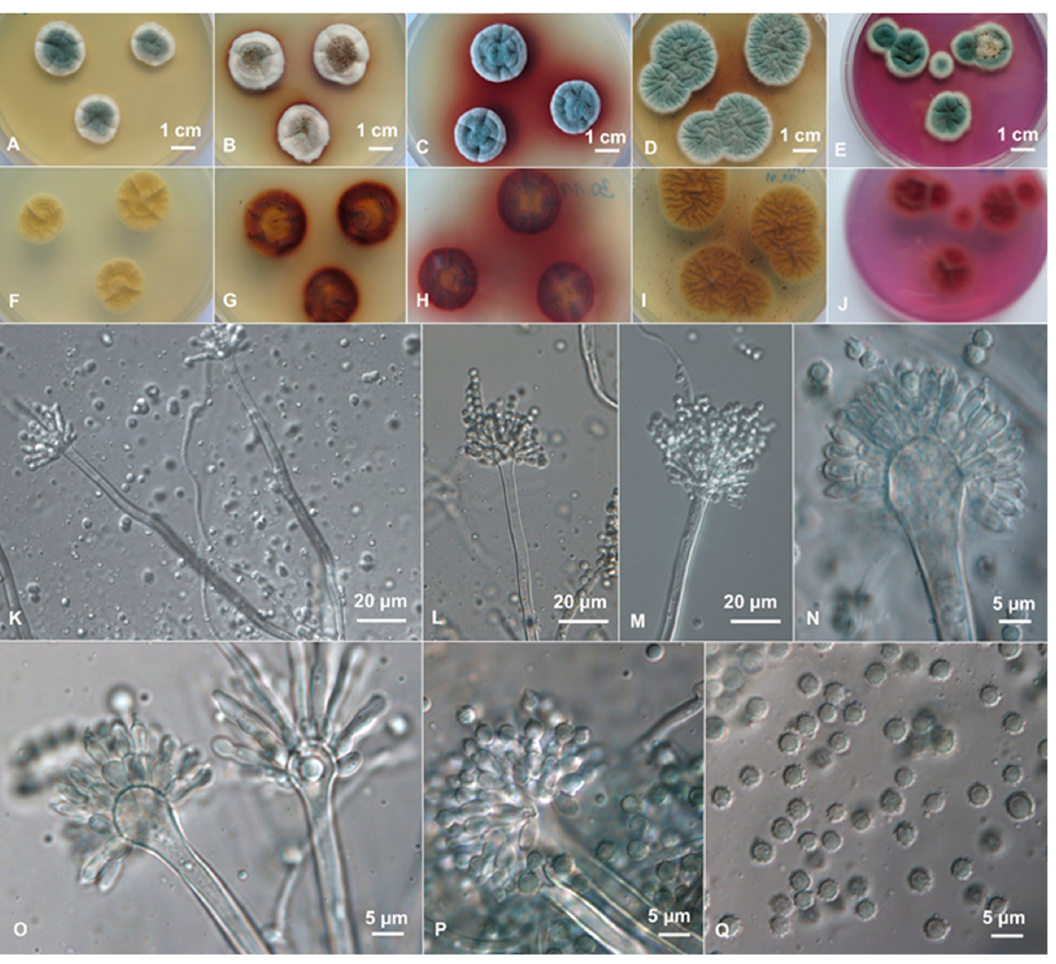
Figure 2. Macro and micromorphology of A. sydowii strain BMH-0004. ( A) malt extract agar